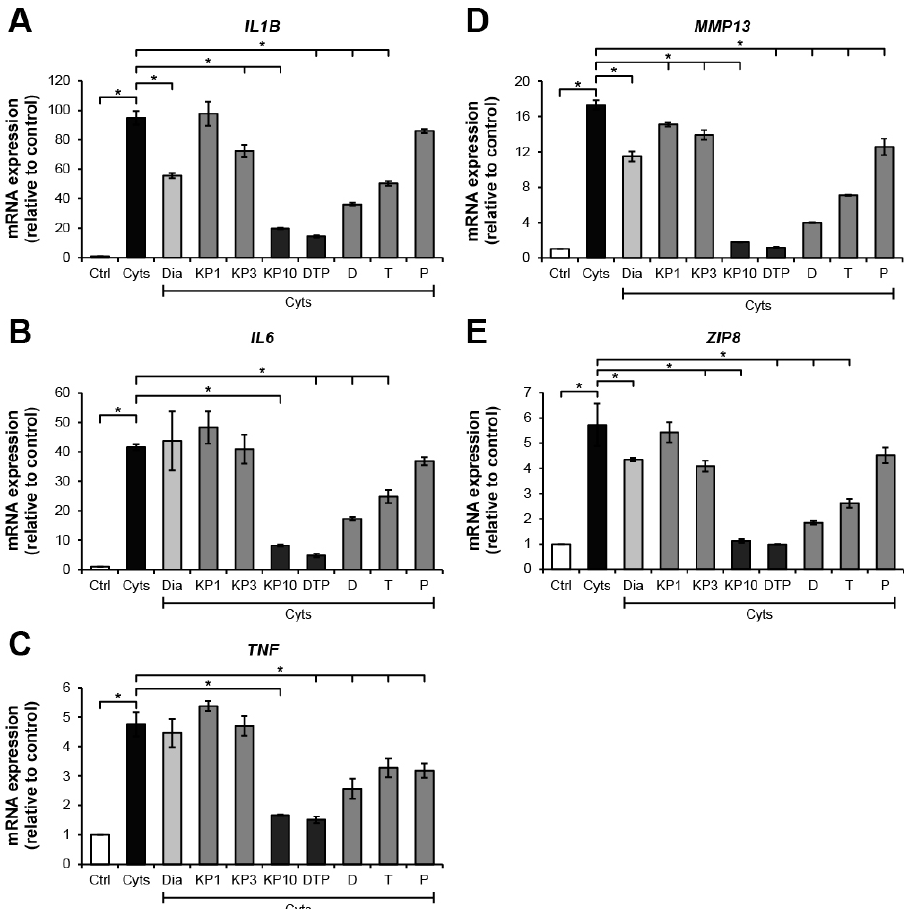
Figure 3. KP extract and its major components suppress arthritis-related gene expressions in SW1353 cells. SW1353 was activated by a combination of 2 ng/mL of IL-1 β and 4 ng/mL of IL-17A (Cyts) for 24 h with or without diacerein (Dia; 50 µ M), KP extract (1, 3, and 10 µ g/mL), 5,7-dimethoxyflavone (D; 3.3 µ g/mL), 5,7,4 (cid:48) -trimethoxyflavone (T; 2.6 µ g/mL), 3,5,7,3 (cid:48) ,4 (cid:48) -pentamethoxyflavone (P; 2.2 µ g/mL) or a mixture of the three major compounds (DTP), which is equal to the estimated proportions in the KP extract at 10 µ g/mL (D: T: P = 3.3: 2.6: 2.2 µ g/mL). Ctrl is an untreated control. The dramatic increase in mRNA expressions of the arthropathy-associated inflammatory cytokines genes, IL1B ( A ), IL6 ( B ),